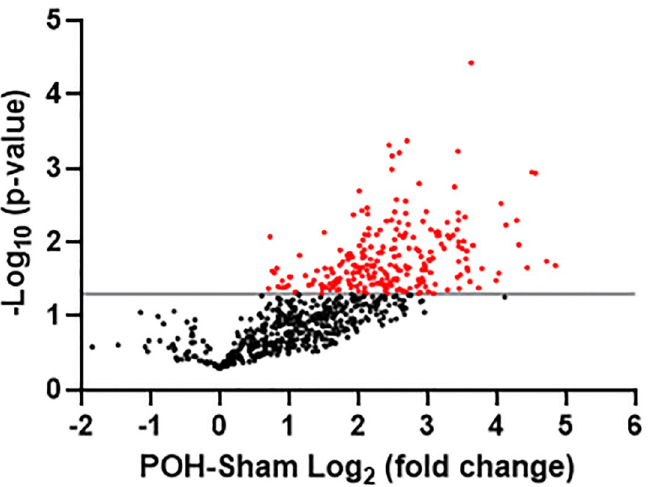
Fig 3. Volcano plot illustrating differentially enriched putative O-GlcNAcylated proteins in pressure-overload hypertrophy (POH) versus Sham. The − log 10 p-value is plotted against the Log 2 fold change in POH versus Sham. Each dot represents a single protein from the 700 total proteins identified in both POH and Sham. Red dots represent proteins with statistically significant enrichment changes (p < 0.05) which is also demarcated by the gray horizontal line. n = 5 per